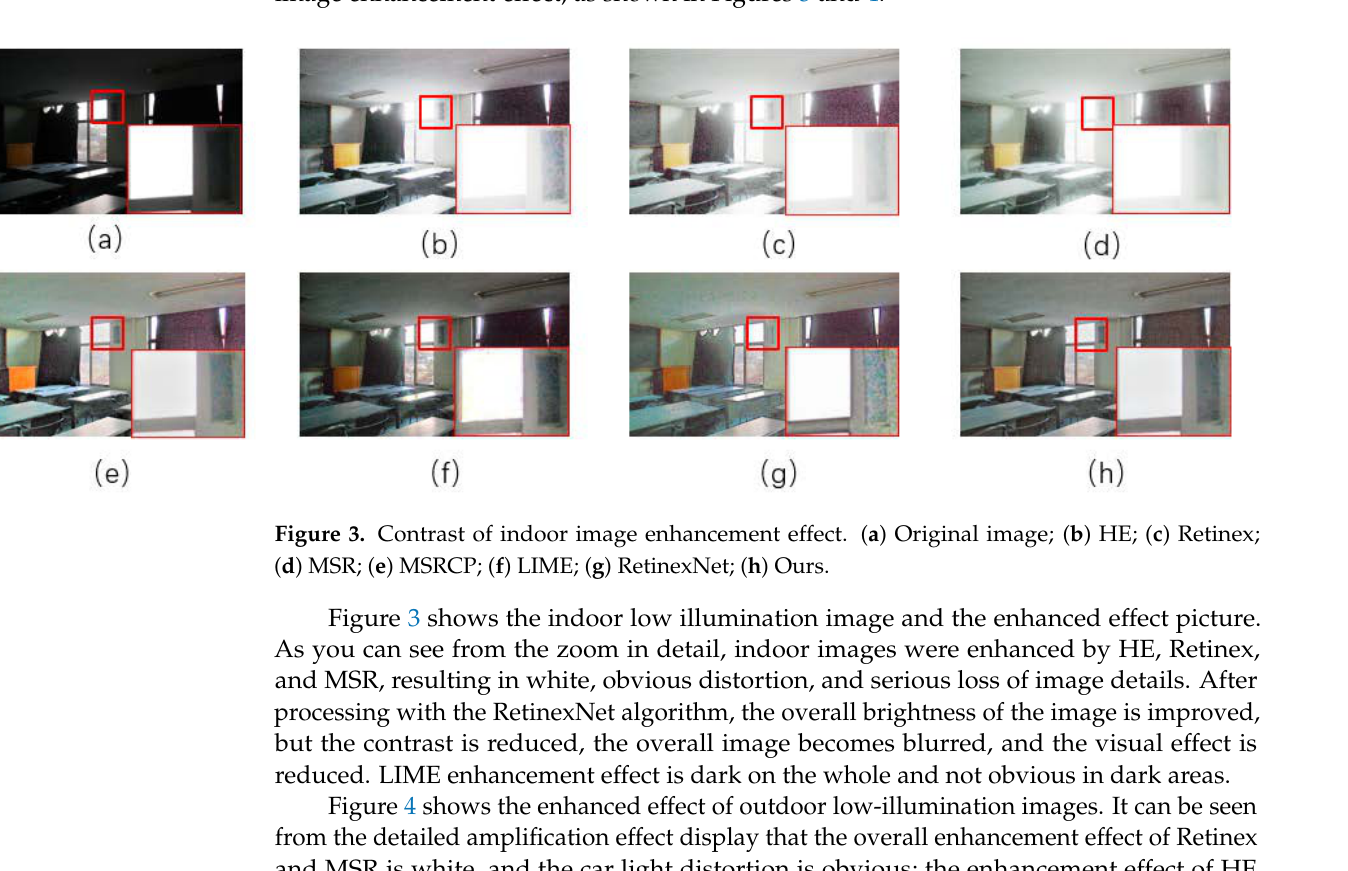
Figure 4. Contrast of outdoor image enhancement effect. ( a ) Original image; ( b ) HE; ( c ) Retinex; ( d ) MSR; ( e ) MSRCP; ( f ) LIME; ( g ) RetinexNet; ( h ) Ours.